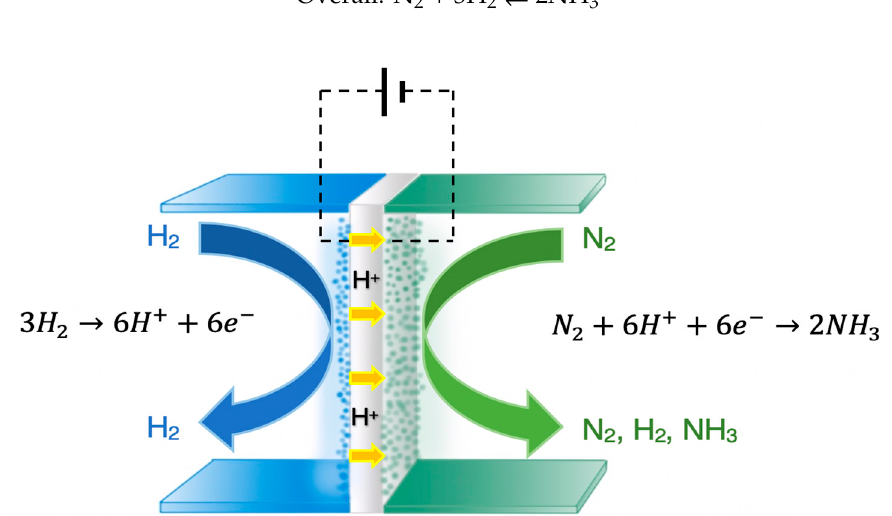
Figure 1. Schematic diagram of a solid state H + conducting cell where NH 3 is produced from gaseous H 2 and N 2 .